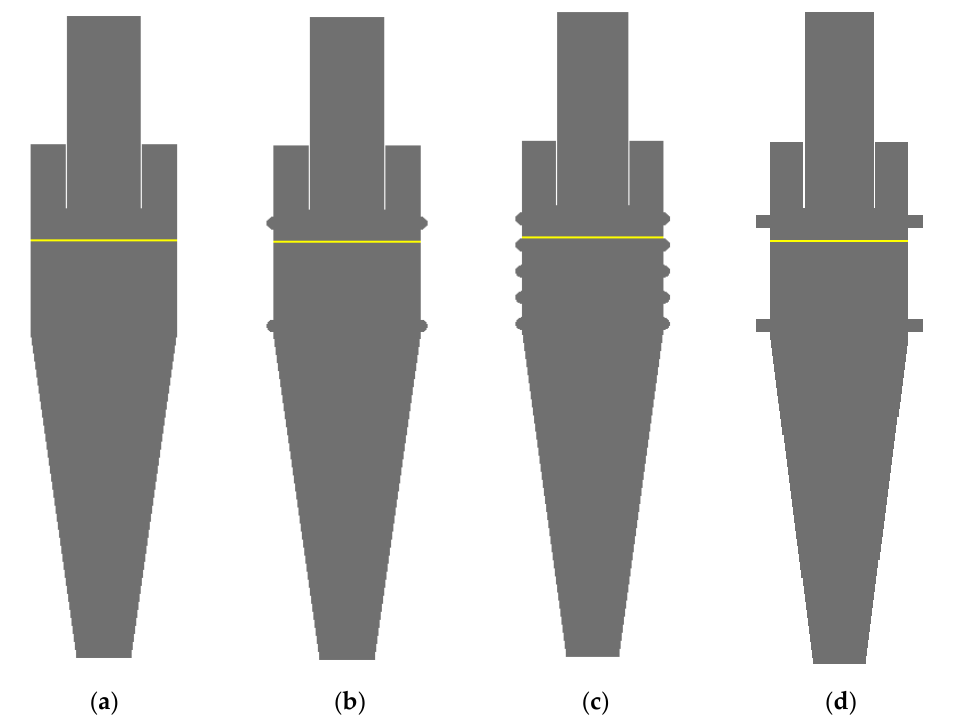
Figure 4. Axial stations and middle planes of cyclones; ( a ) Stairmand cyclone separator, ( b ) Model B